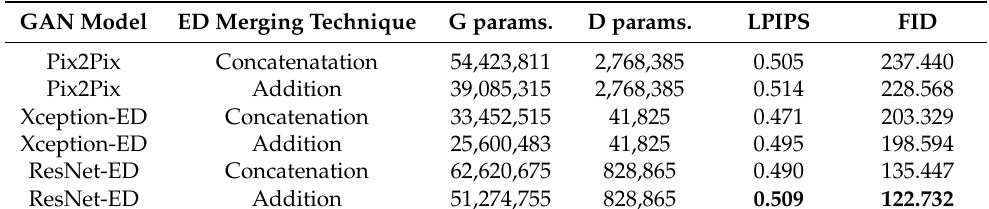
Table 1. Comparison between the proposed GAN models trained on NYU depth V2 with 14 semantic labels in terms of the generator and discriminator parameter count (G params. and D Params.) LPIPS and FID metrics.